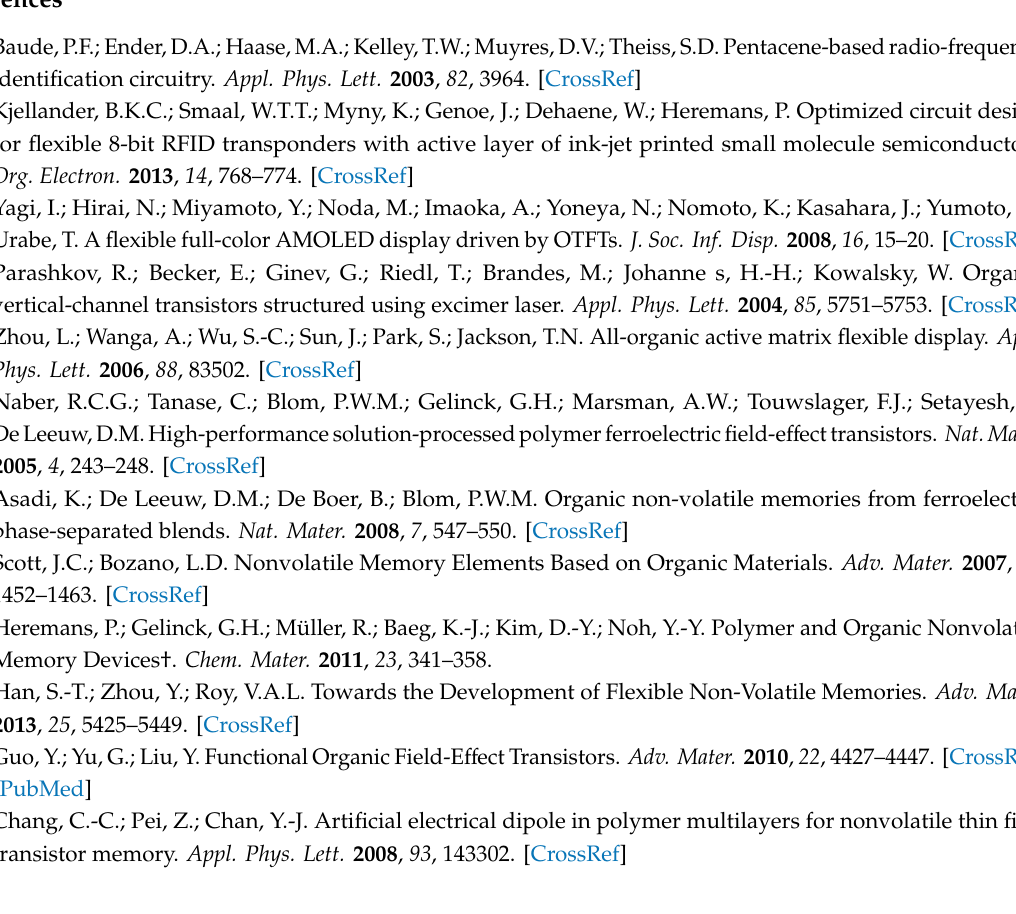
440). Figure S3: DSC spectra of PMLG and PBLG. Figure S4: Strong interaction causes high crystallinity in PBLG. Table S1 FWHM and lattice spacing from XRD